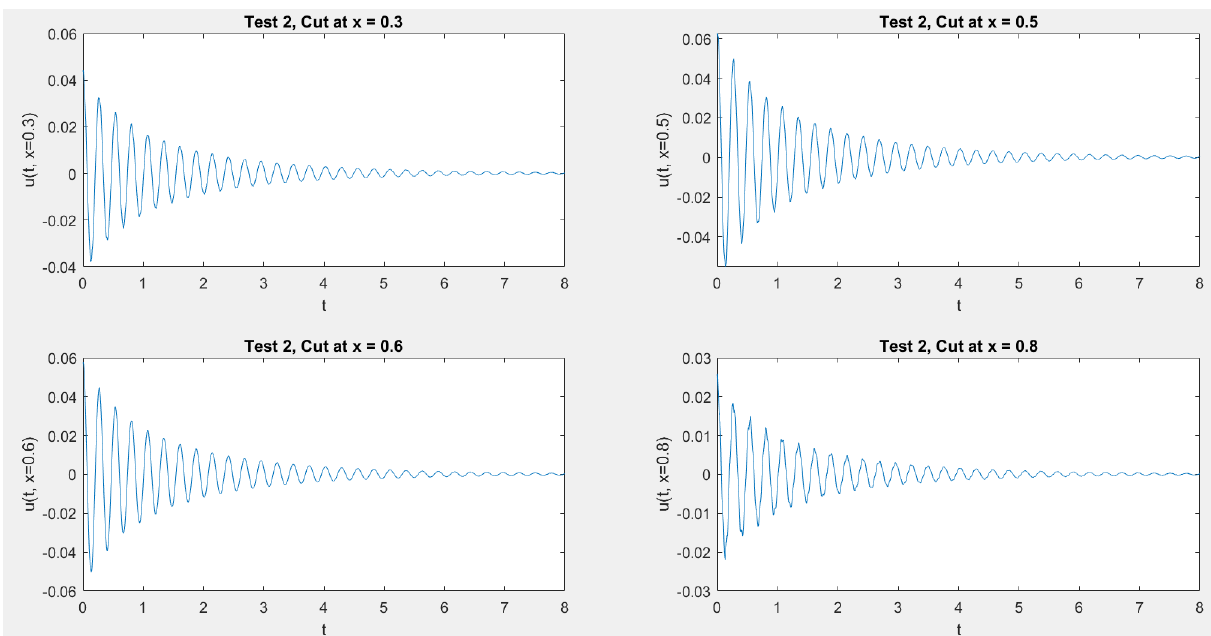
Figure 1. Test1: The solution. u ( t ) at fixed values of x .